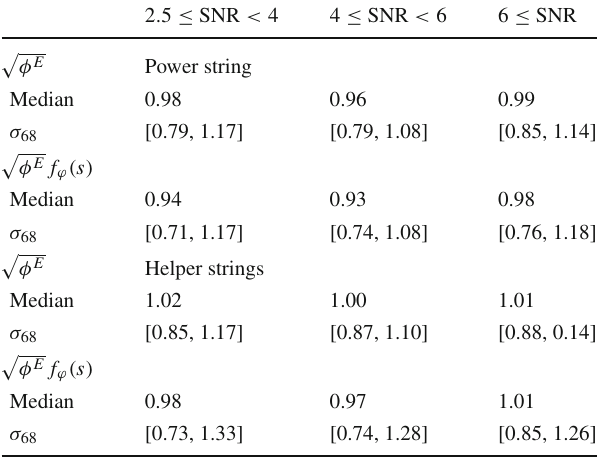
Fig. 13 Ratio of the square root of the energy fluence multiplied with the correction factor f ϕ ( s ) for the viewing angle defined in Eq. (4) calculated from the reconstructed and the actual radio signal at the power string (top) and each of the two helper strings (bottom). For events where s > 10, f ϕ ( s (cid:6) ) was used instead. Events are divided into categories by the maximum signal-to-noise ratio of the channels used in the reconstruction. The outermost bins are overflow bins Table 3 Median and 68% quantiles σ 68 of the ratios between recon- structed and actual square root of the energy fluence shown in Fig. 12, (cid:3) φ E f ϕ ( s ) calculated from as well as between the energy estimators the reconstructed and the actual electric field shown in Fig. 13. Shown are results for the channel groups at the bottom of the power string and of the helper strings, as well as for different maximum